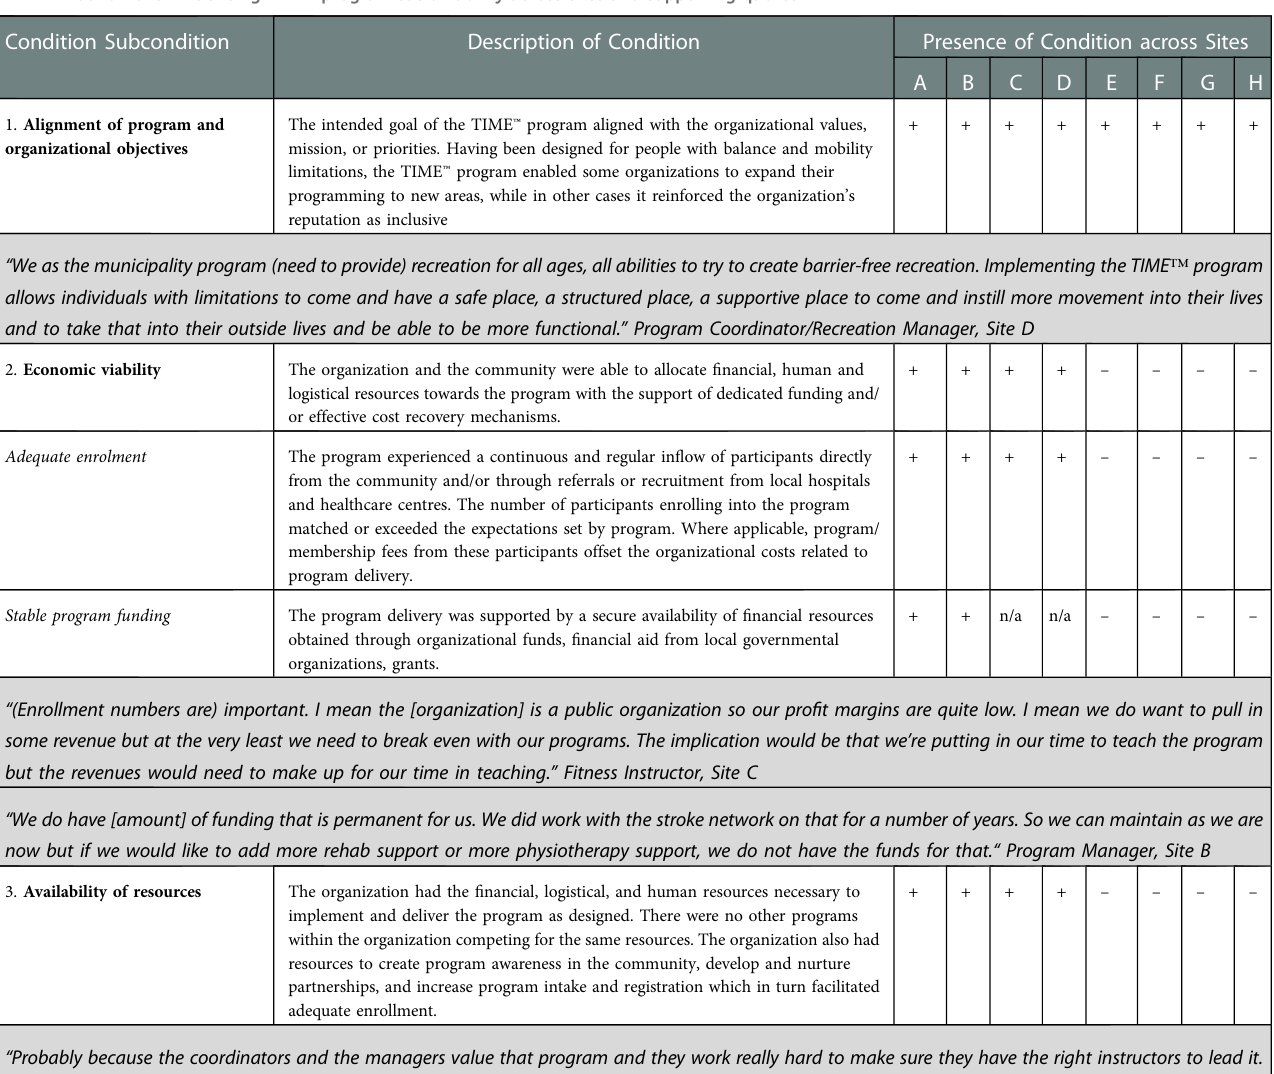
TABLE 4 Conditions in fl uencing TIME ™ program sustainability across sites and supporting